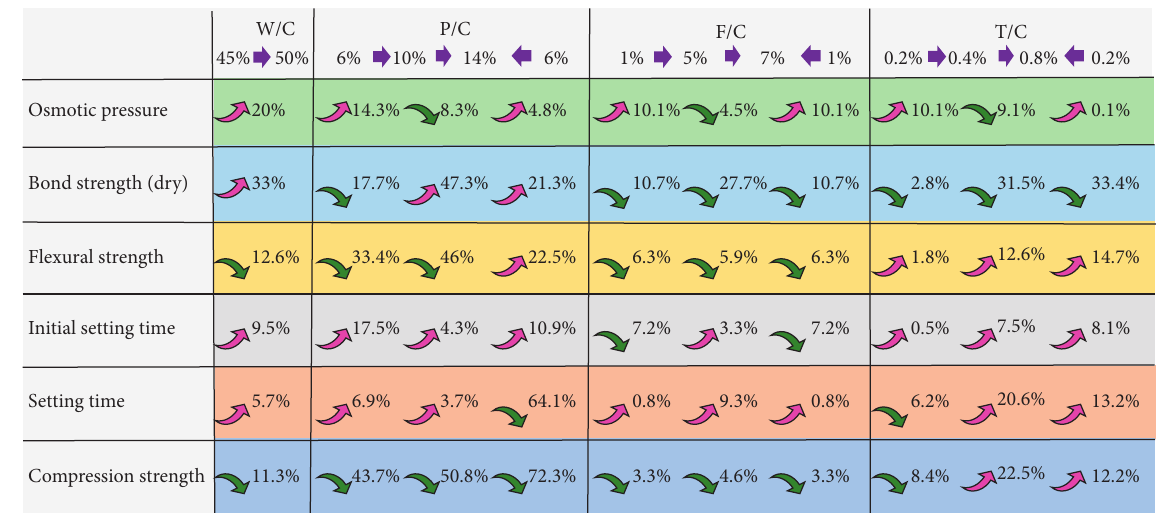
Figure 14: Influence of gradient variation of different factors on the dry wall on indicators.